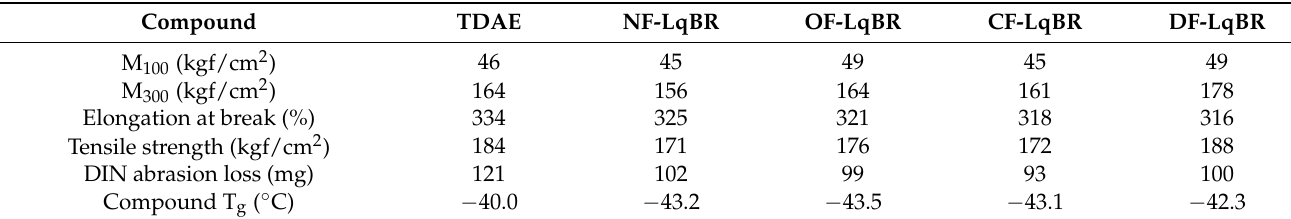
Figure 8. Stress–strain curves of the vulcanizates according to the applied processing aids. Table 9. Mechanical properties and DIN abrasion loss of the vulcanizates.